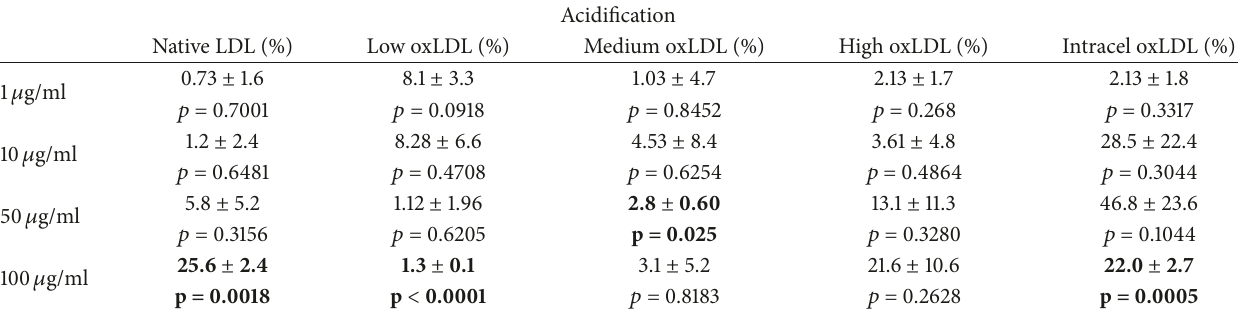
Table 4: Extracellular acidification rates of various LDL exposure to macrophages. Mean peak MAMP height changes and standard errors for each experimental condition during exposure. All 𝑝 values are calculated based on peak height versus 10min average basal value prior to exposure. Terms in bold are representative of 𝑝 < 0.05 , indicating statistical significance.